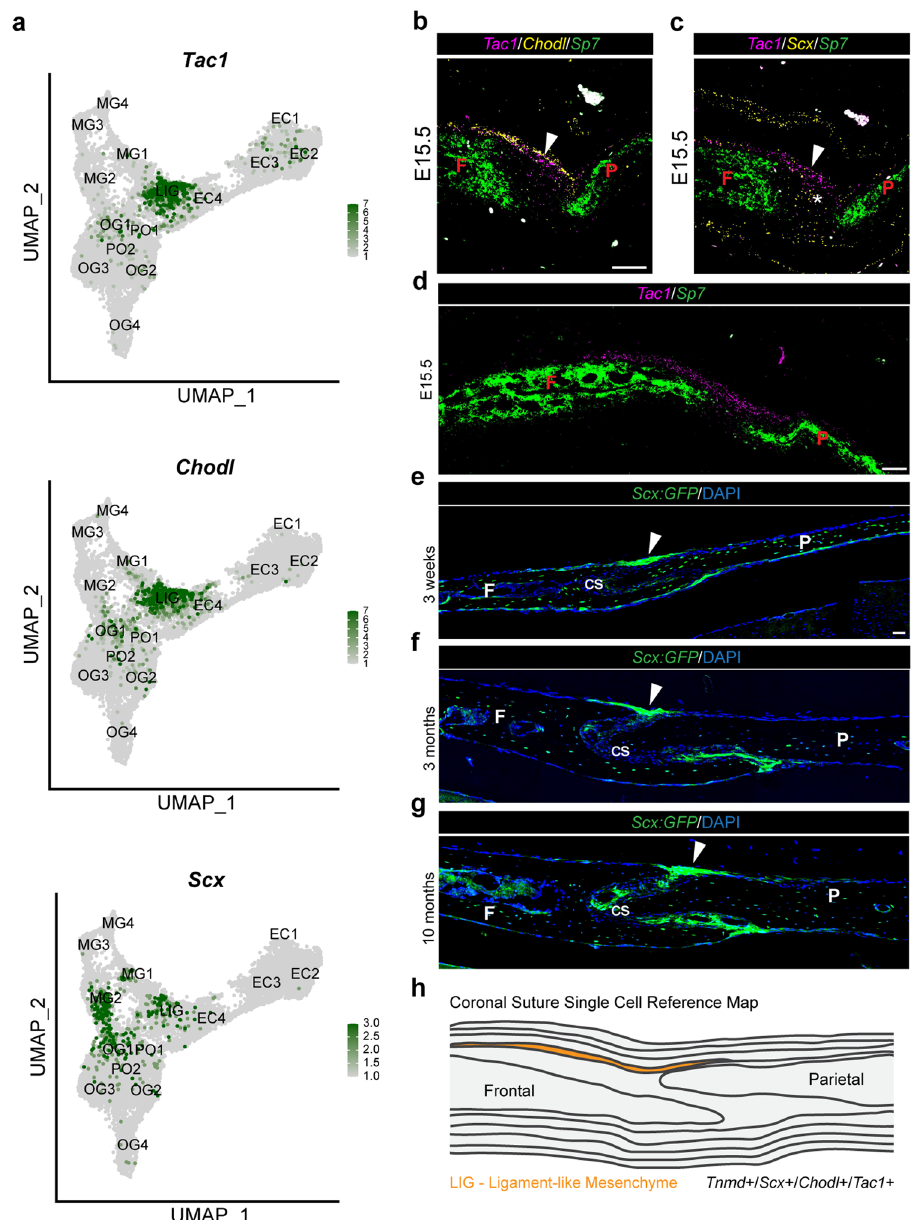
Fig. 4 Ligament-like mesenchyme above the coronal suture. a Feature plots of genes validated by in situ experiments. b – d Combinatorial in situ analysis of coronal sutures for indicated markers at E15.5. Sp7 marks the frontal (F) and parietal (P) bones. Arrowheads denote the ligament-like population, and the asterisk suture mesenchyme weakly labeled by Scx . e – g At the indicated postnatal stages, Scx-GFP labels a ligament (arrowheads) in a similar position to the embryonic ligament-like population ( n = 2 per stage). Nuclei are labeled by DAPI. h Model summarizing location of the LIG layer. cs = coronal suture. In situs were performed in biological triplicate. Scale bars = 50 µ m; images ( b , c ) are at the same magni fi cation, as are ( e – g